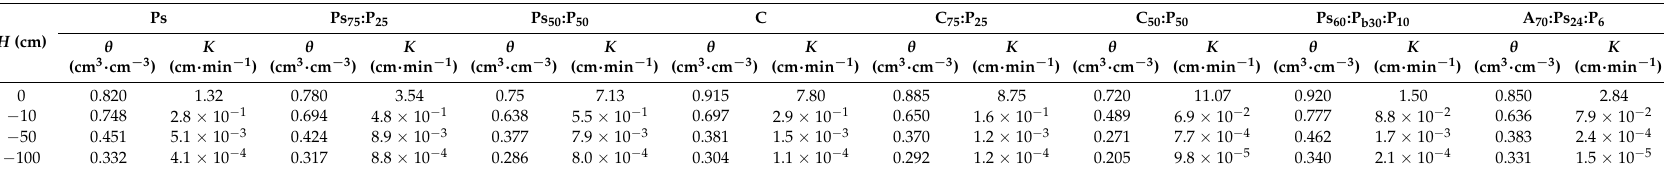
Table 5. Measured values of water content and hydraulic conductivity at saturation ( H = 0 cm) and those predicted by the Mualem–van Genuchten model at water pressure heads within the range of easily available water and water buffering capacity ( H = − 10, − 50, − 100 cm), as introduced by De Boodt and Verdonck [24], for the